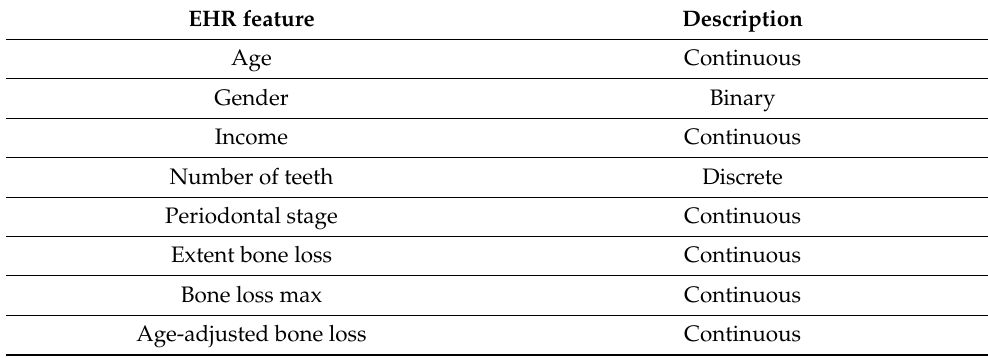
Table 1. The eight demographic and clinical features. EHR feature